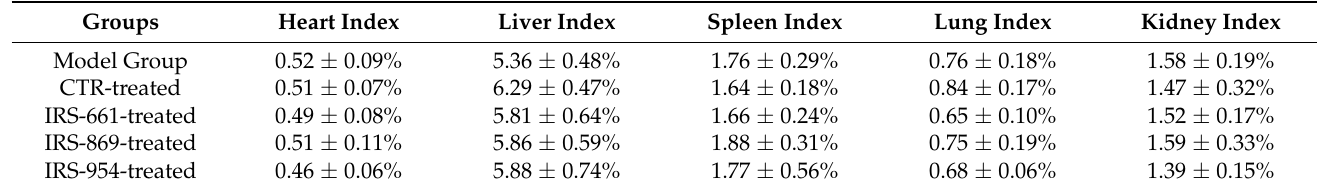
Table 2. Weight ratio of each